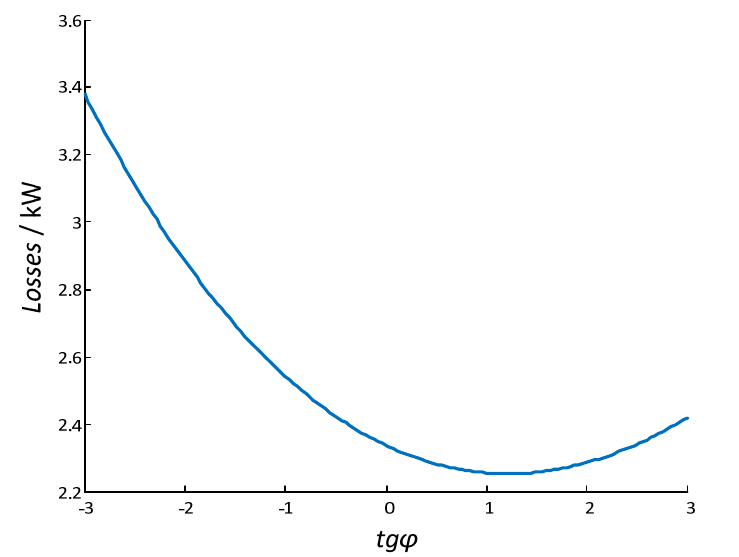
Figure 14. Example of calculated feeder losses as a function of uniform tg φ for one operating point when consumption was high.